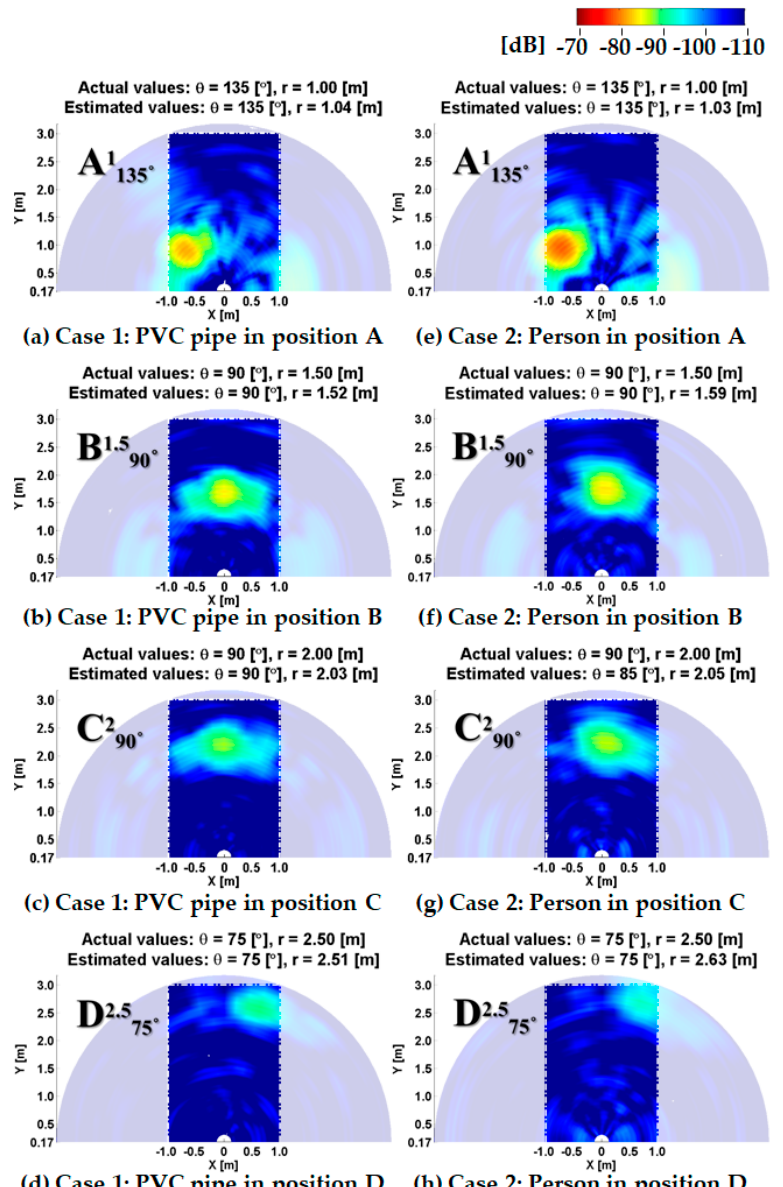
Figure 8. Energy maps of Case 1 and Case 2 for verification of the localization performance in an anechoic chamber: The Case 1 of a PVC pipe in ( a ) position A; ( b ) position B; ( c ) position C; ( d ) position D; Case 2 of a person in ( e ) position A; ( f ) position B; ( g ) position C; ( h ) position D.